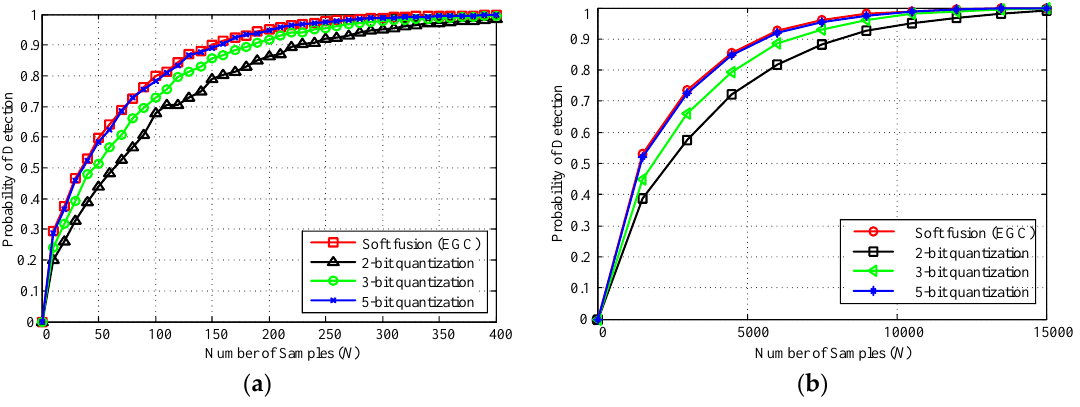
Figure 8. The probability of detection versus the number of samples ( Q f = 0.05, M = 4) ( a ) SNR = −8 dB ( b ) SNR = −16 dB.